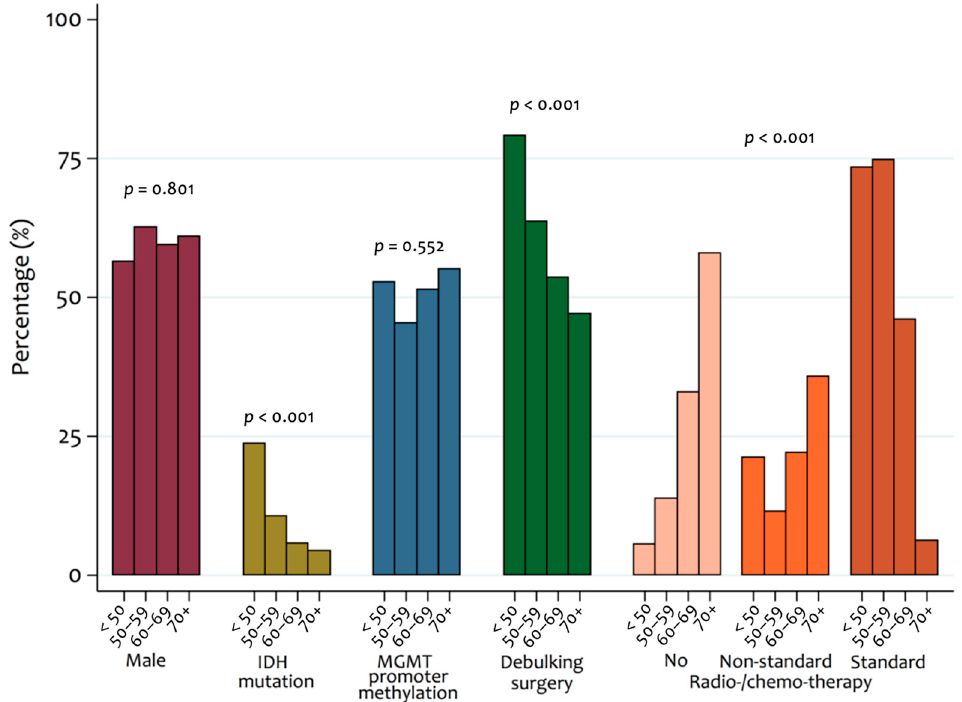
Figure 1. Patient characteristics by age category. p -values indicate the significance of observed differences between age groups for each variable.